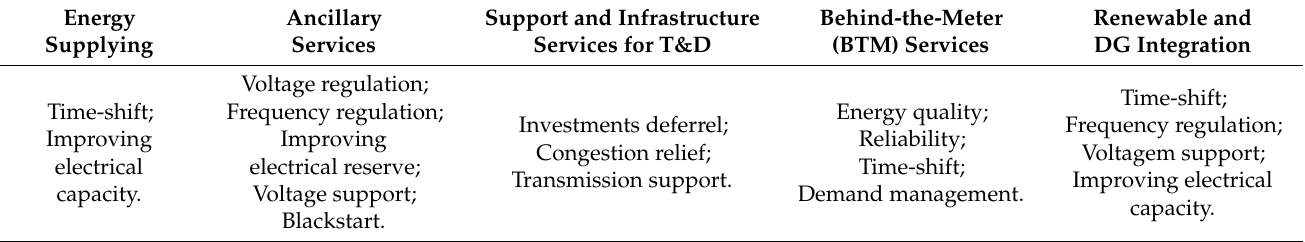
Table 3. Categories and applications of ESS technology in the electrical